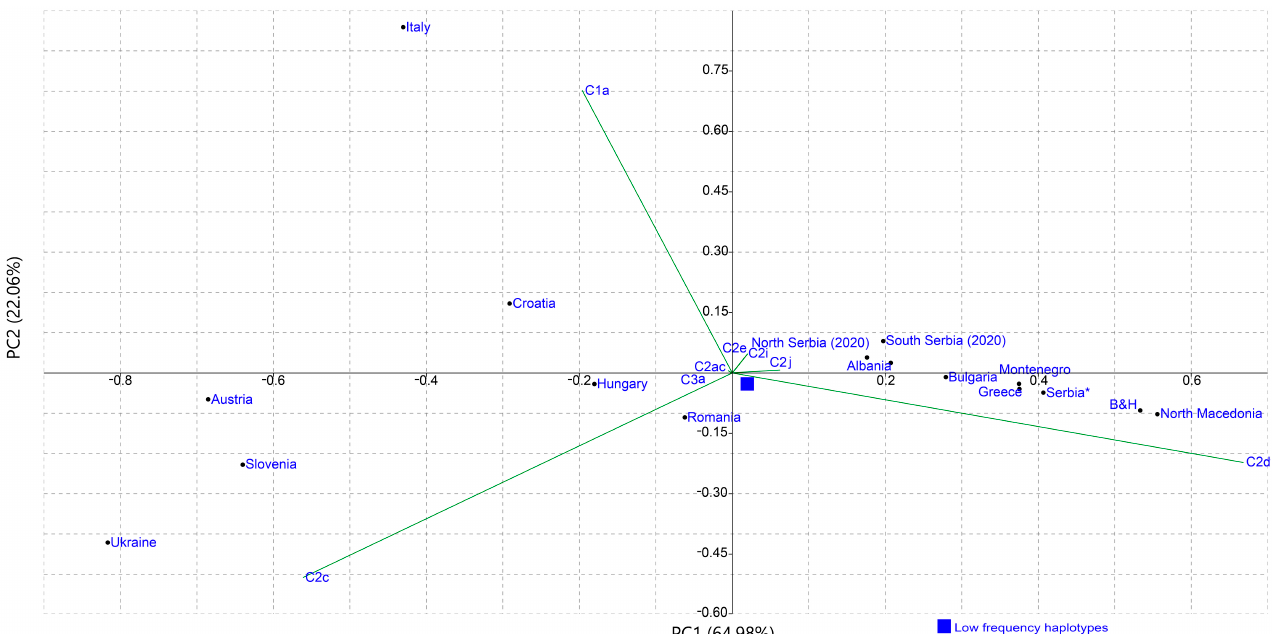
Figure 6. PC analysis based on mtDNA haplogroup frequencies in different A. mellifera populations. The contribution of each haplogroup to the PCs is shown with green lines. Frequencies of mtDNA haplogroups and references are listed in Tables S2 and